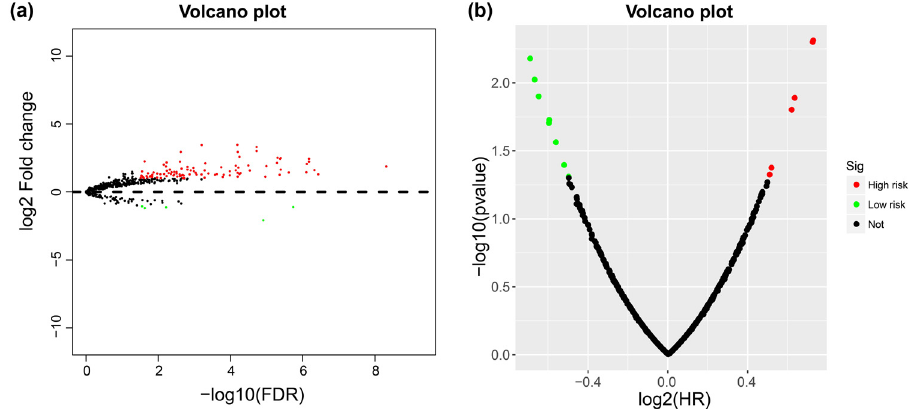
Figure 1: Volcano plot of fold change and survival analysis of snRNAs in GC: ( a ) volcano plot of the fold change of snRNAs in GC; ( b ) volcano plot of prognosis analysis of snRNAs in GC.